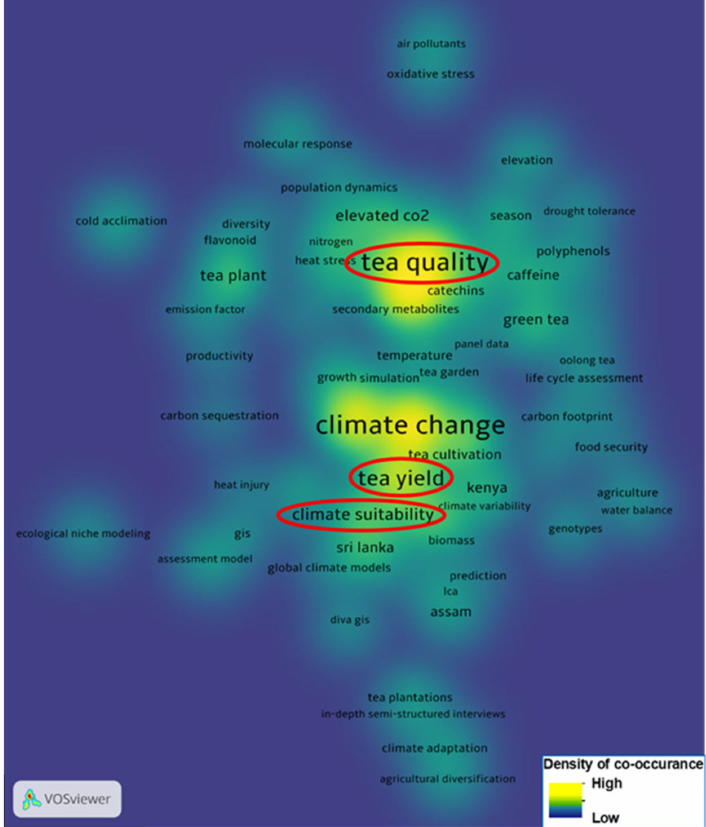
Figure 1. Visualization of the co-occurrence density of keywords from 762 papers on climate change and tea ( Camellia sinensis ). Note: As a threshold level, two nodes were